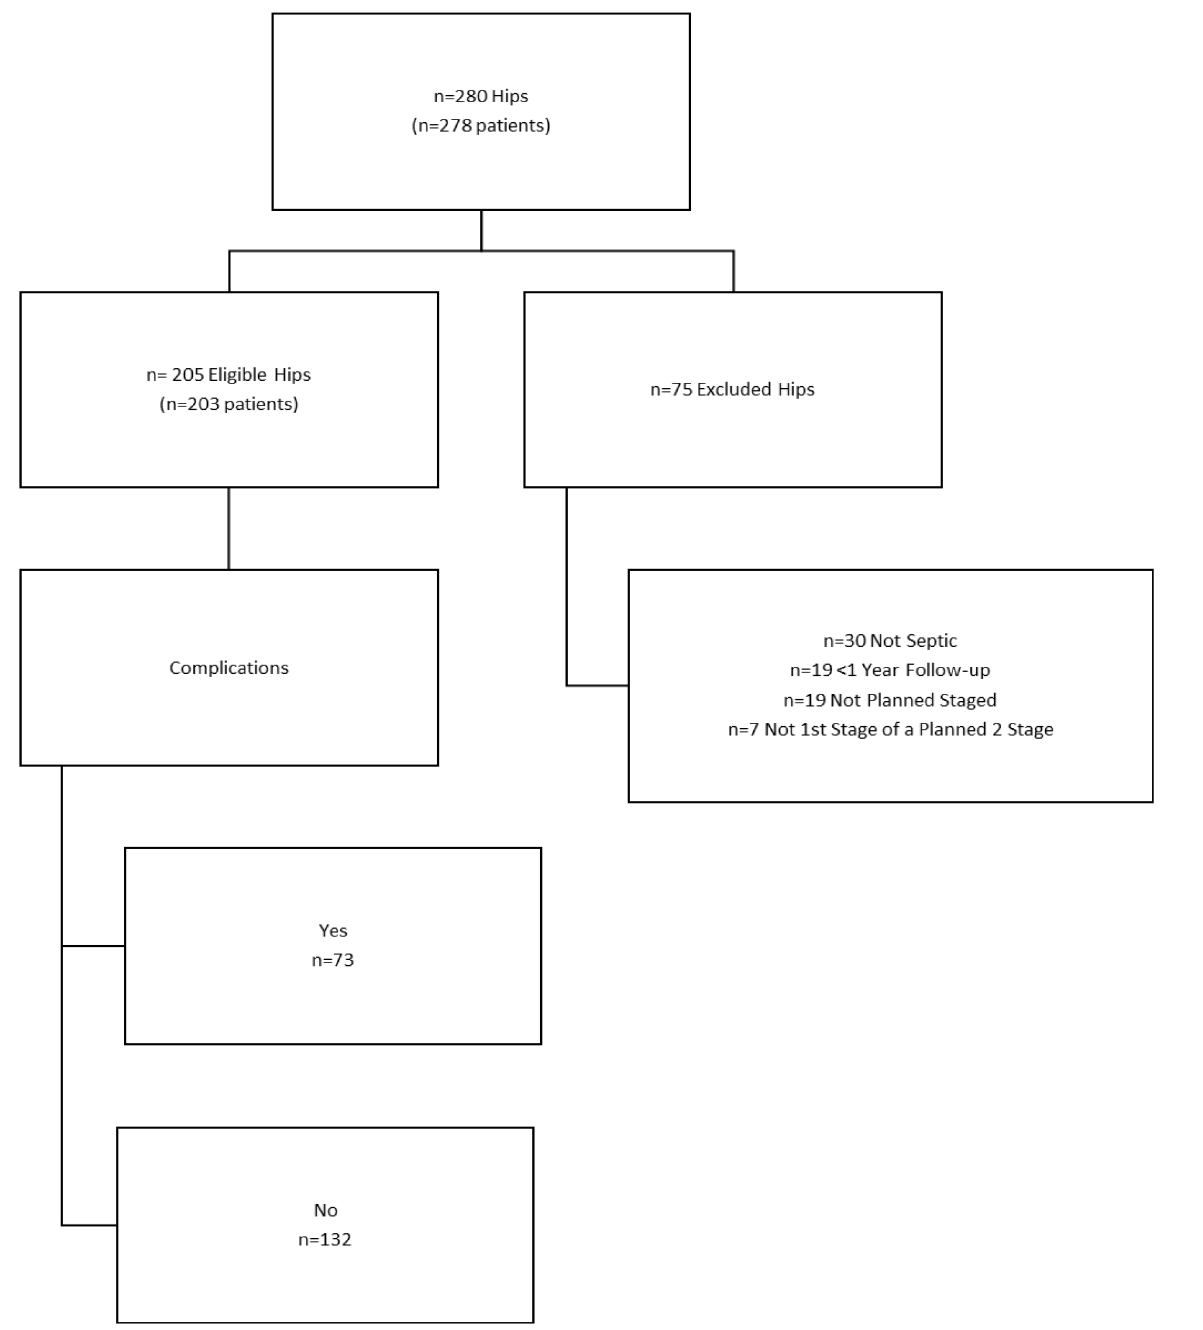
Figure 1. CONSORT (Consolidated Standards of Reporting Trials) flow diagram of eligible patients for two-stage exchange arthroplasty for chronically infected total hip arthroplasty (THA). All deceased patients and those with a retained spacer are included.